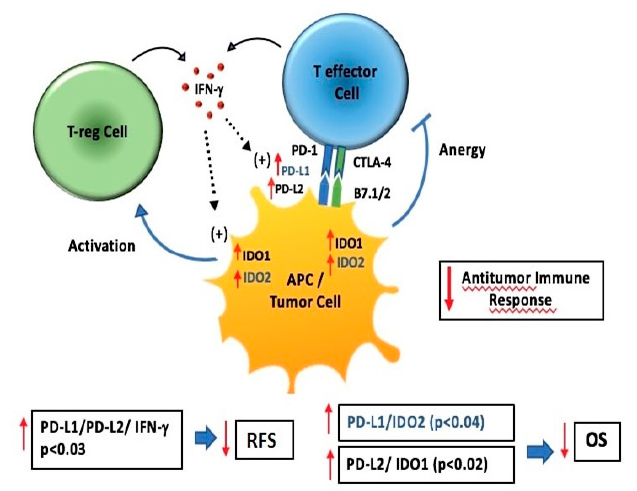
Figure 4. IDO-1, IDO-2, PD-L1, PD-L2 and INF γ interactions within the tumor microenviroment. IDO signaling pathways exert immune suppressive function by the activation of T-reg cell and the anergy of T effector cell. PD-L1/PD-1 inhibits T effector cell proliferation and stimulates T-reg cell proliferation while INF γ upregolates PD-L1, PD-L2 and IDO expression. Immune suppressive microenviroment promotes tumor growth increasing risk of progression (poor RFS) and unfavorable prognosis (worse OS).